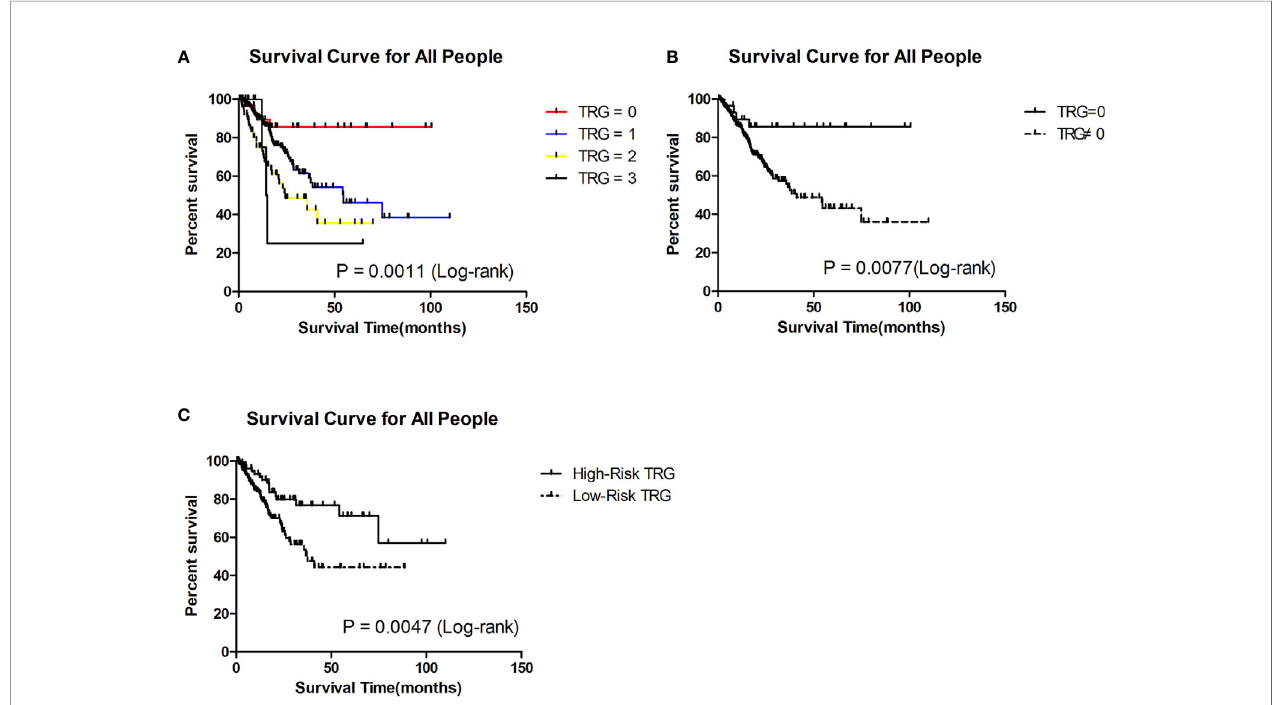
FIGURE 1 | Survival analysis of patients in different TRG group in the retrospective cohort. (A) Survival analysis of patients between 0, 1, 2 and 3 grade TRG group. (B) Survival analysis of patients between TRG = 0 and TRG ≠ 0 group. (C) Survival analysis of patients between low-risk and high-risk TRG